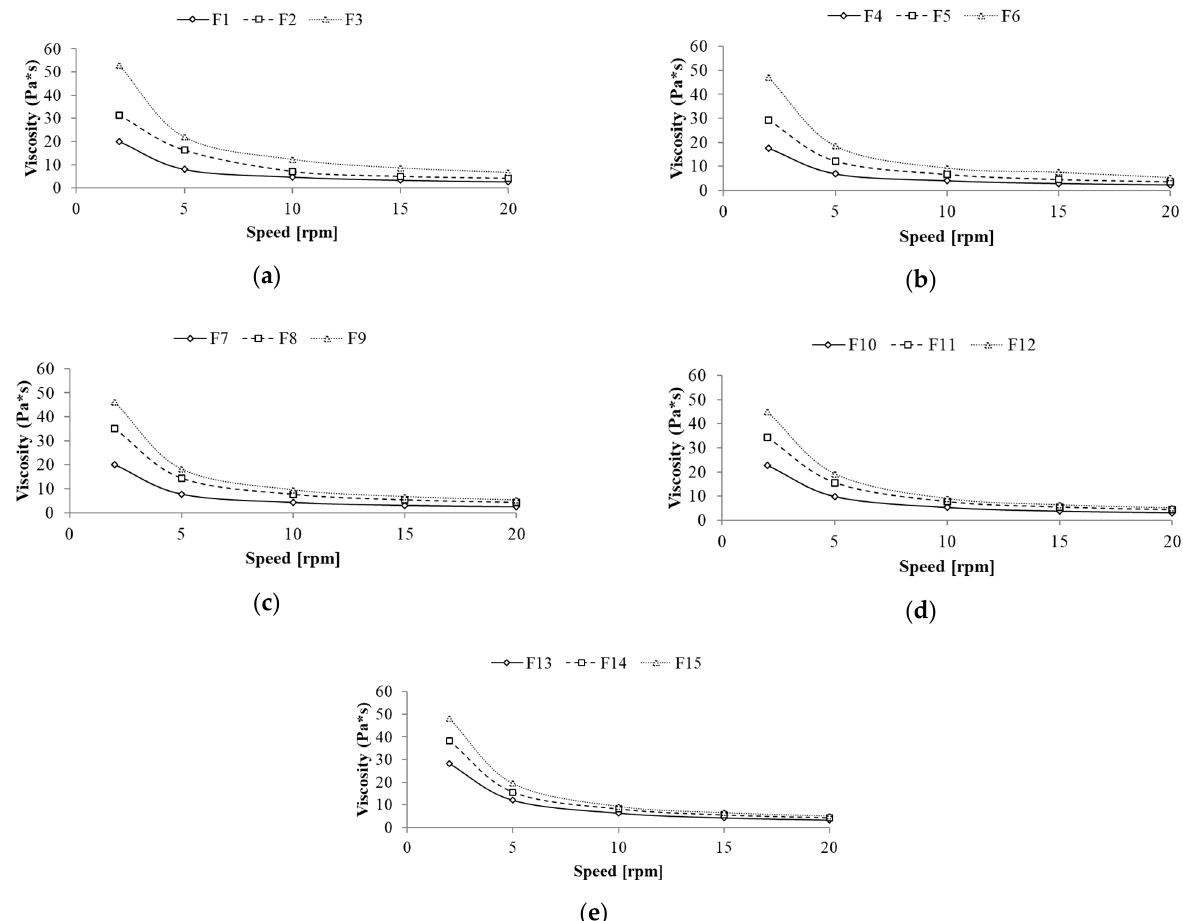
Figure 4. Rheological behavior of the freshly prepared emulsions with a following MT:HSO ratio in an oil phase: ( a ) 3:1 w/w , ( b ) 3:2 w/w , ( c ) 3:3 w/w , ( d ) 2:3 w/w and ( e ) 1:3 w/w .